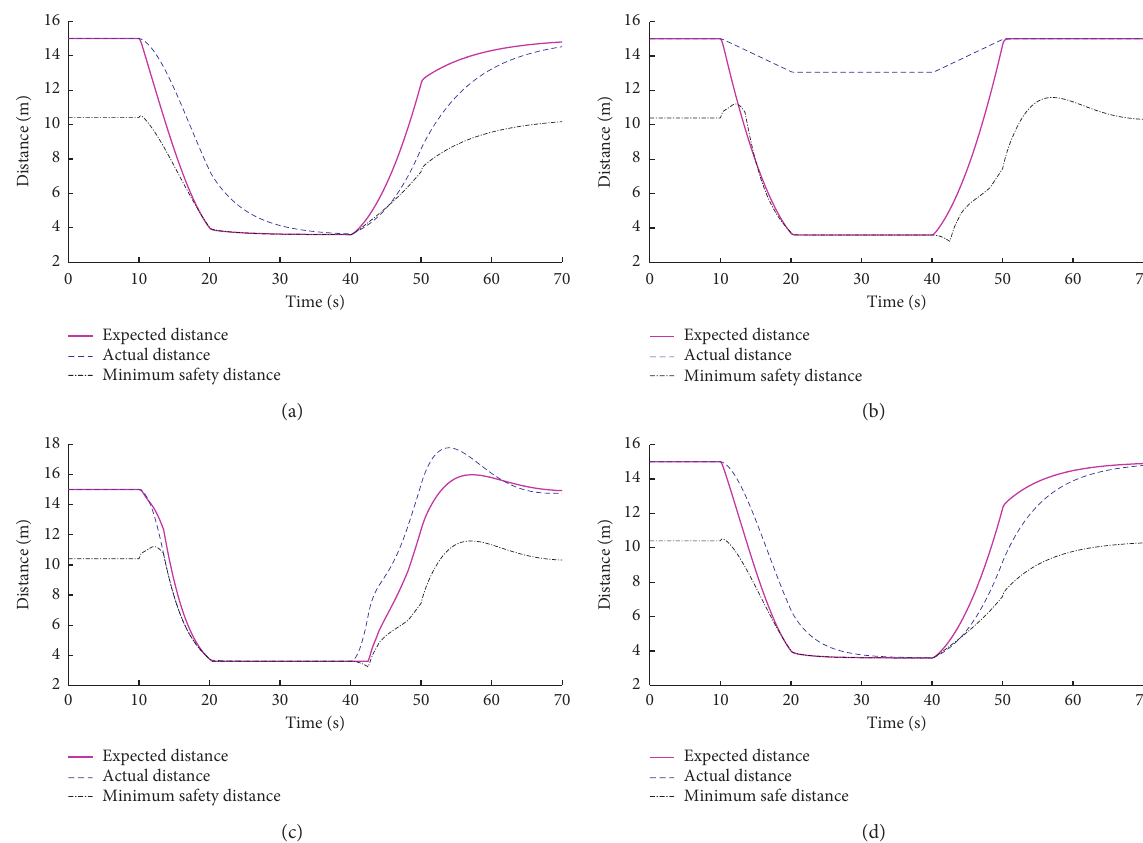
Figure 17: Distances of the LV and the FV of four controllers. (a) The MPC controller based on Quadprog. (b) The Incremental PID controller. (c) The Switch controller. (d) The MPC controller based on SDNN.